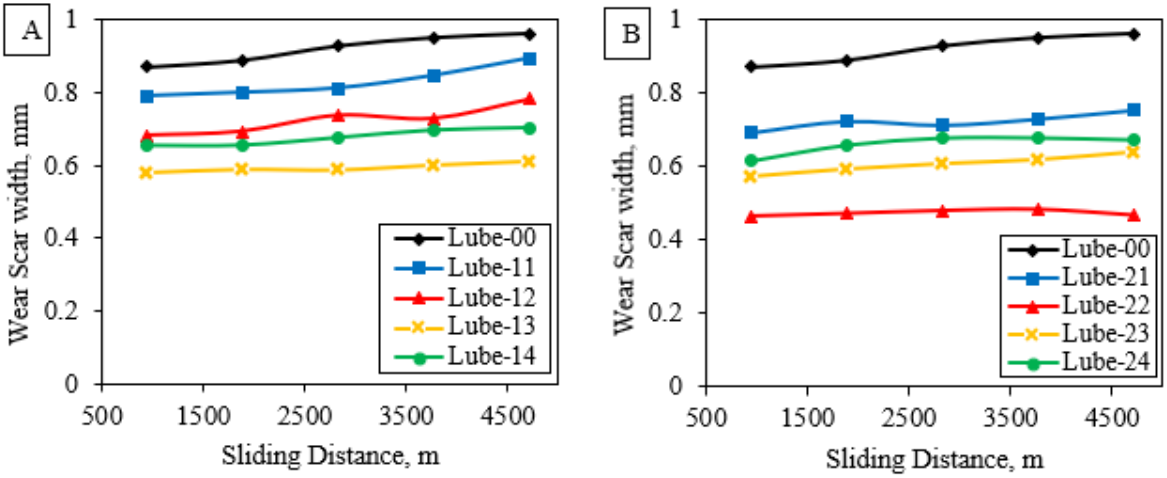
Figure 7. Wear scar width of hybrid nano lubricant samples: ( A ) 0.5 wt.% MWCNTs and ( B ) 1.0 wt.% MWCNTs.